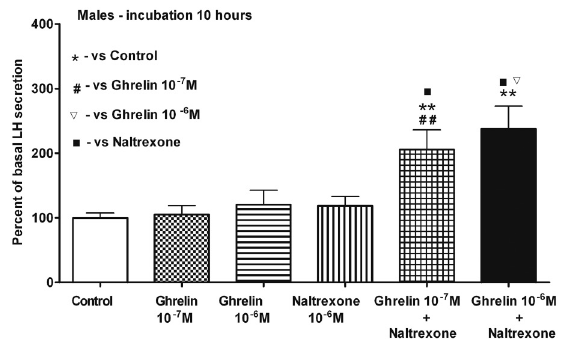
Fig. 4. Percentage of basal LH secretion from male pitu- itary cells incubated for 24 h with control medium, human ghrelin at 10 –7 or 10 –6 M, naltrexone (10 –6 M) or the combination of naltrexone with ghrelin at 10 –7 or 10 –6 M; Bars represent means and SEM are given as vertical error bars ( n = 5). **( P < 0.01) vs. control; # ( P < 0.05) vs. ghrelin 10 –7